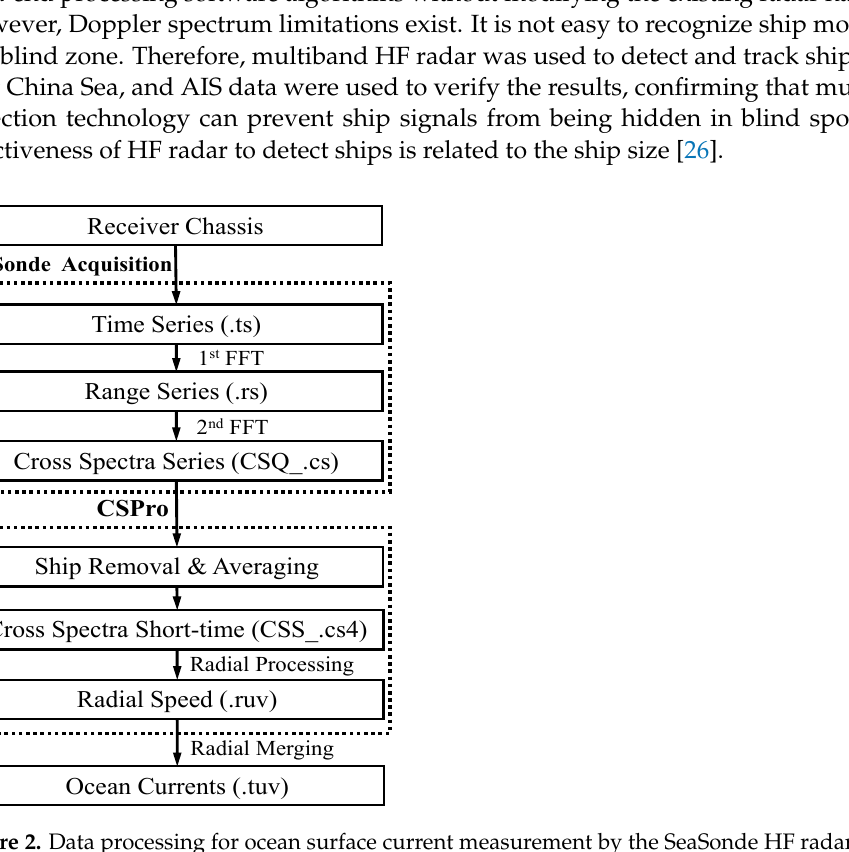
Figure 2. Data processing for ocean surface current measurement by the SeaSonde HF radar system.